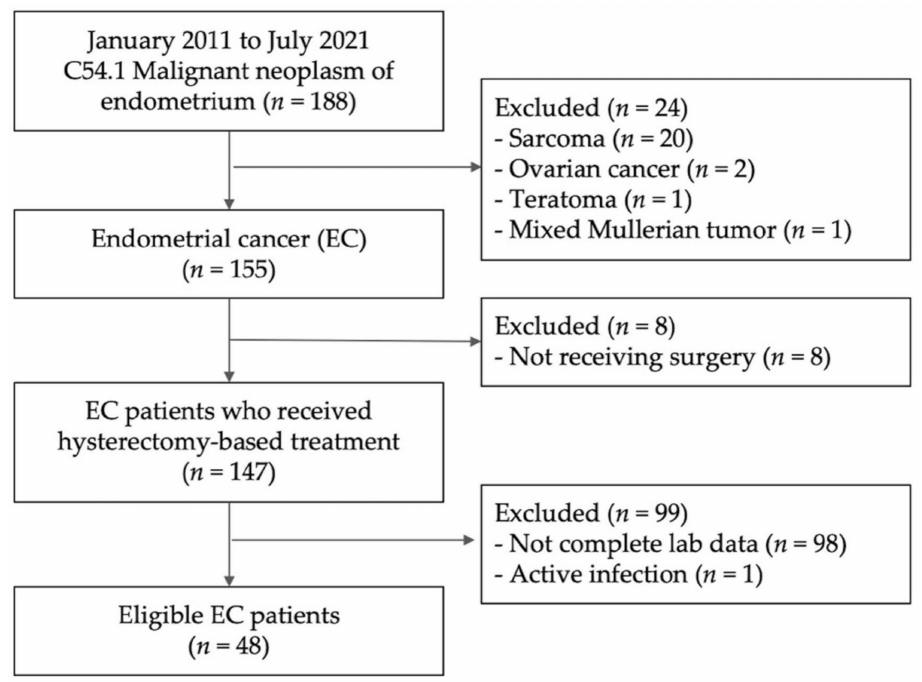
Figure 1. Flowchart describing the patient selection for the study. EC: endometrial